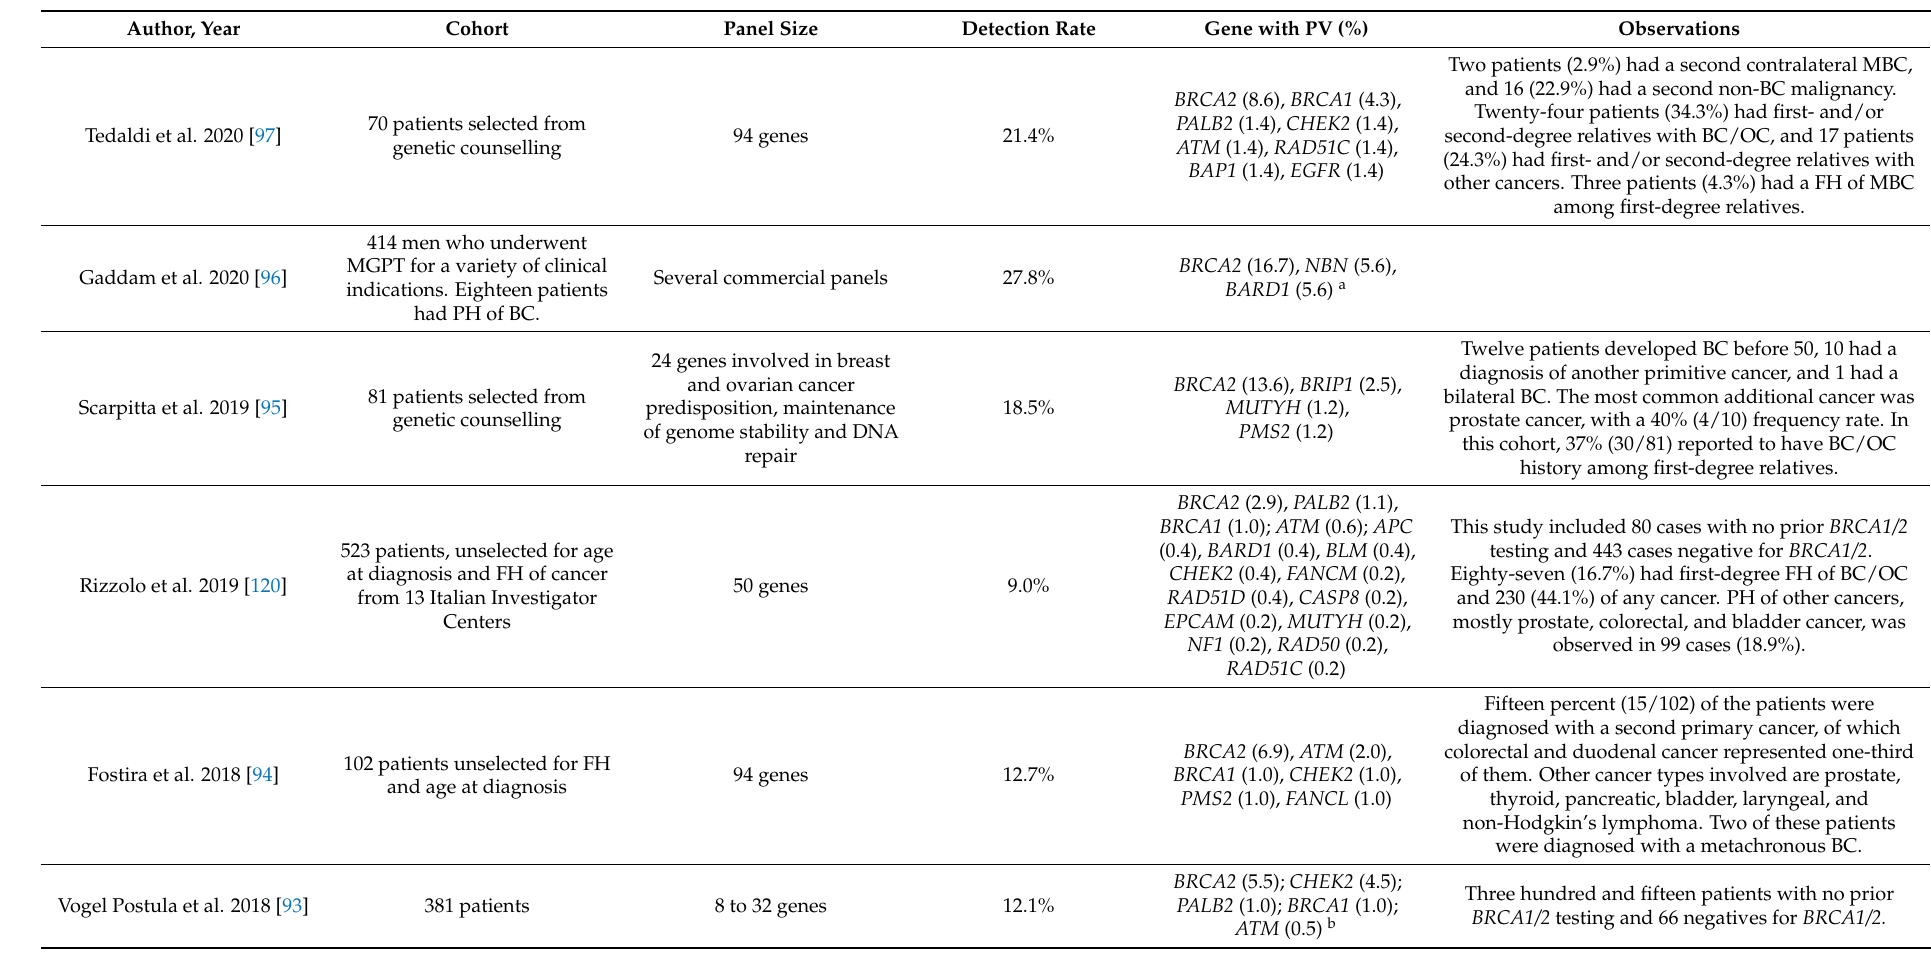
Table 2. Studies performing multigene panel testing in MBC